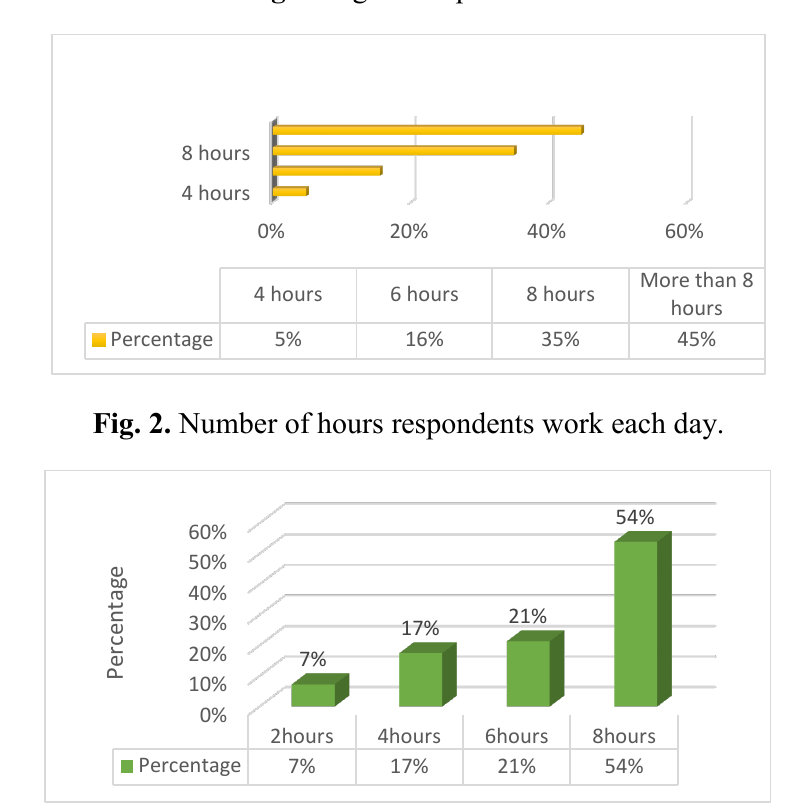
Fig. 3. Number of hours respondents are exposed to risk